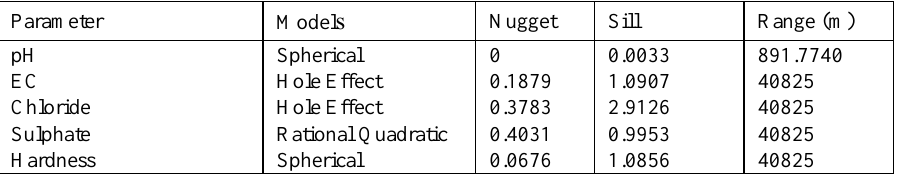
Table 3. Semivariogram model parameters for ground water quality factors